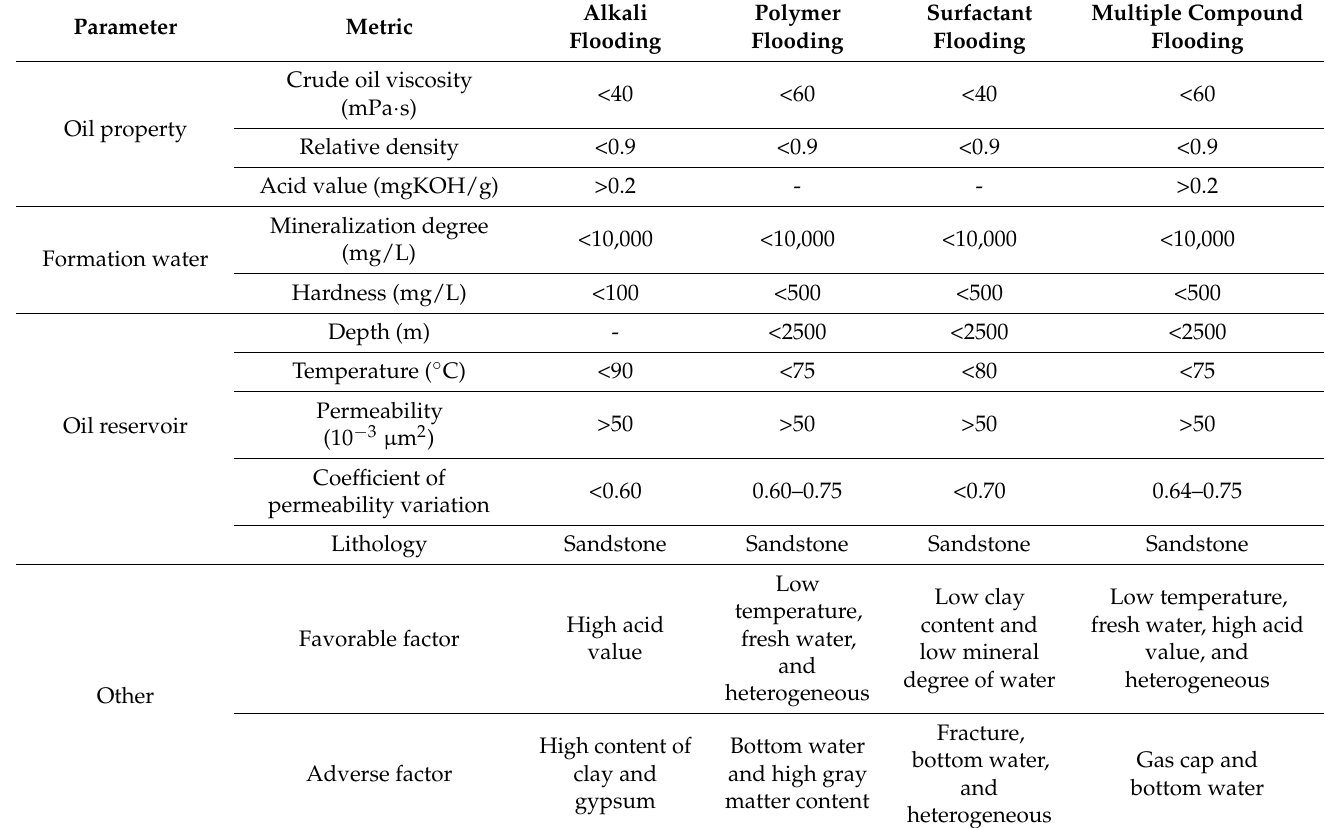
Table 2. Screening standards suitable for chemical flooding